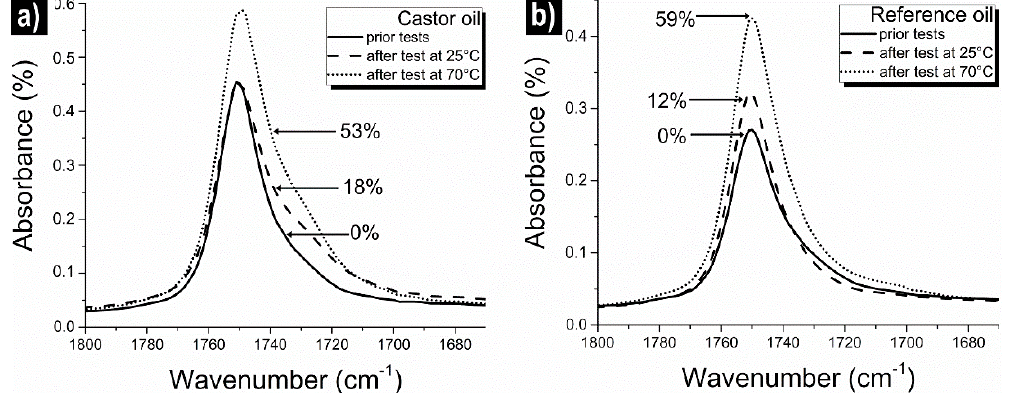
Figure 11. Evaluation of carbonyl band (C=O) of Castor ( a ) and Reference ( b ) oil before and after tribological tests at 25 and 70 °C.